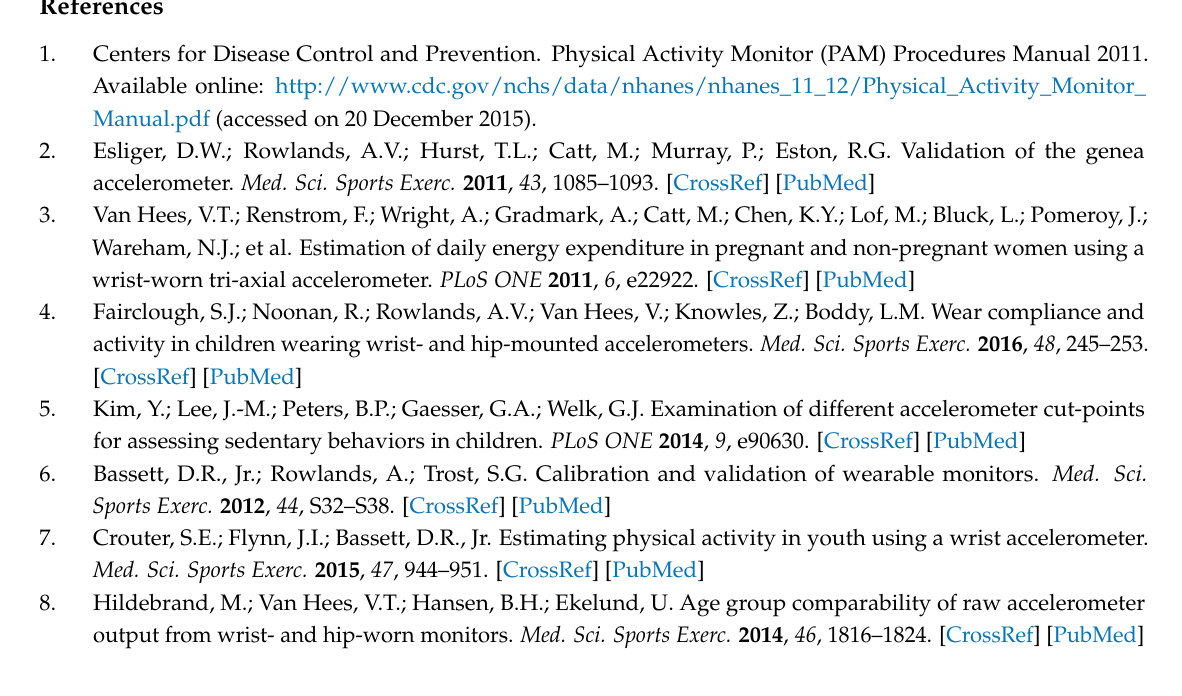
Figure S1: Distribution of counts/5 s epoch for each sedentary activity versus